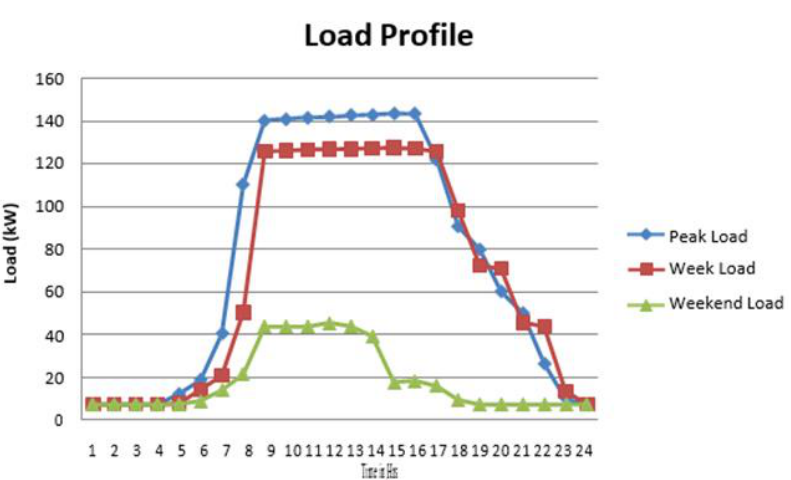
Figure 12. Load profile induction furnace industry. Influence of VPP on the Energy Charges